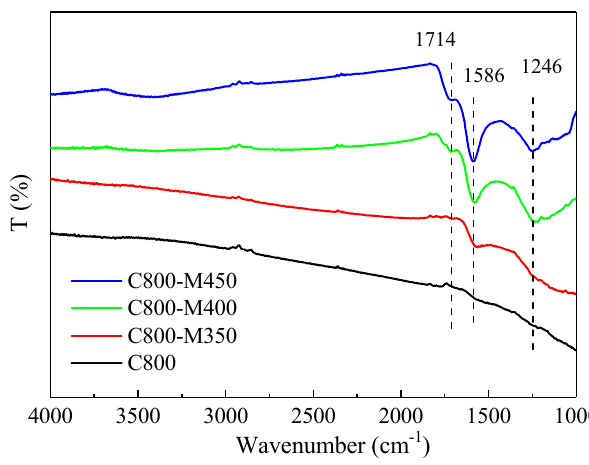
Figure 5. Fourier transform infrared (FTIR) spectra of wood-derived porous carbons materials.